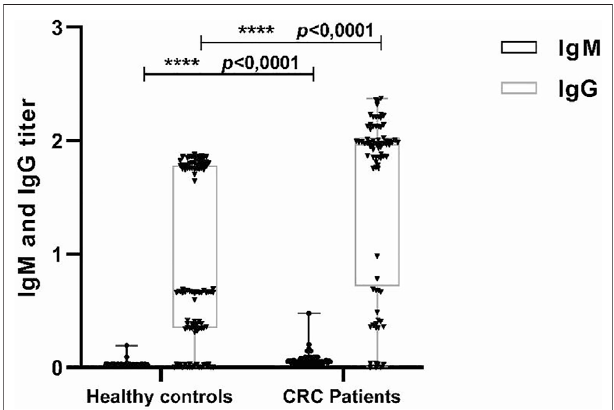
FIGURE 4 | Detection of IgG and IgM antihuman cytomegalovirus (HCMV) in sera from colorectal cancer (CRC) and control patients. Sera were detected by enzyme-linked immunosorbent assay (ELISA) using anti-CMV IgG and IgM test kit. The median of IgG titers to HCMV in CRC patients and control patients were 1.96 versus 0.6710, while the IgM titers to HCMV were 0.019 versus 0.049. *** p (cid:1) 0.0001, *** p (cid:1) 0.0001.